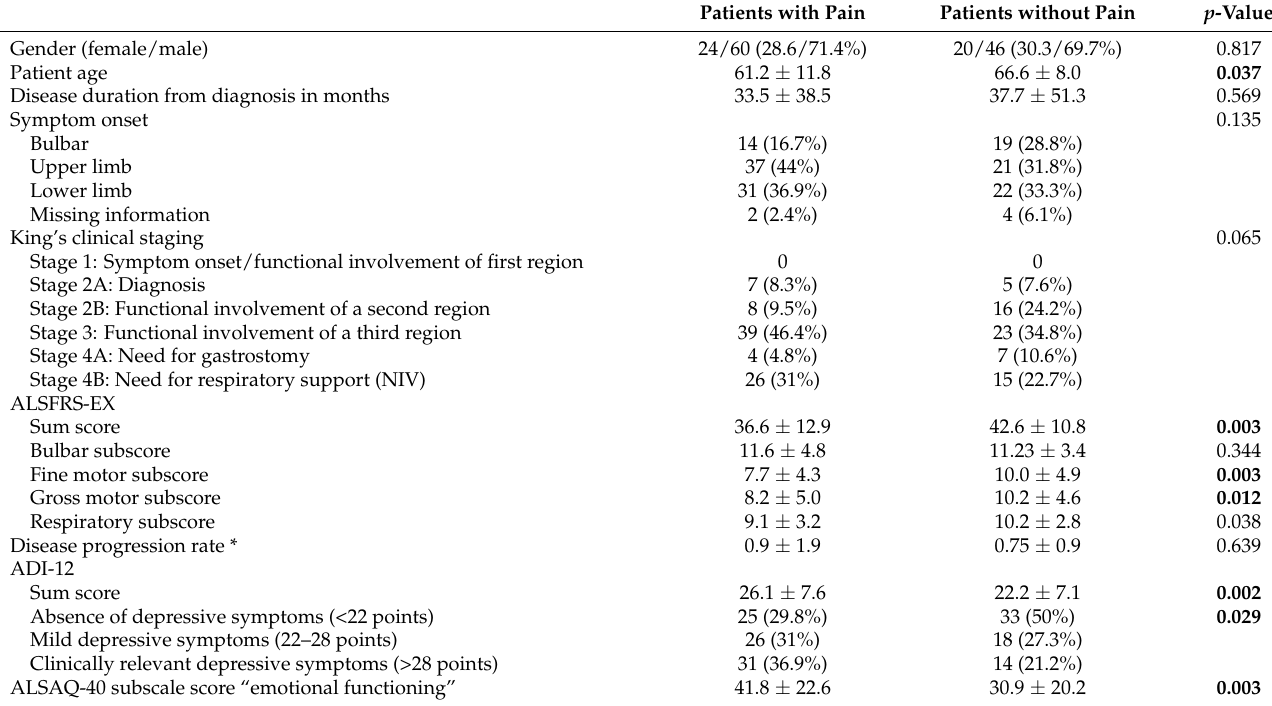
Table 1. Demographic and clinical data as well as results from patient reported outcomes of ALS patients with and without pain (mean ± SD or number of patients (%), as appropriate).